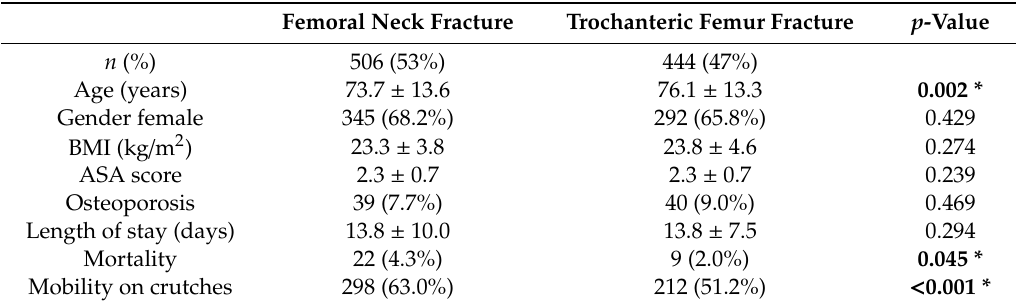
Table 1. Baseline characteristics and outcomes depending on fracture